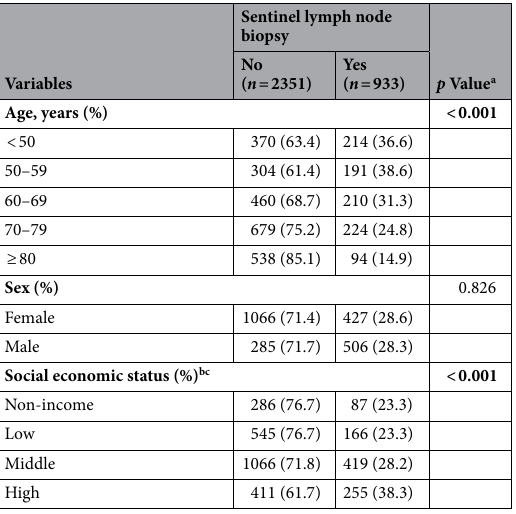
Table 3. Percentage of patients undergoing SLNB in different age, sex, SES categories ( n = 3284). a Using Chi-square test. Bold type indicates statistical significantly ( P < 0.05). b Social economic status was classified